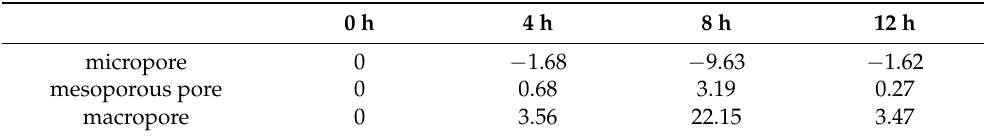
Figure 15. Proportion of pore size of saturated sandstone in the freezing process. Table 6. Aperture ratio change rate